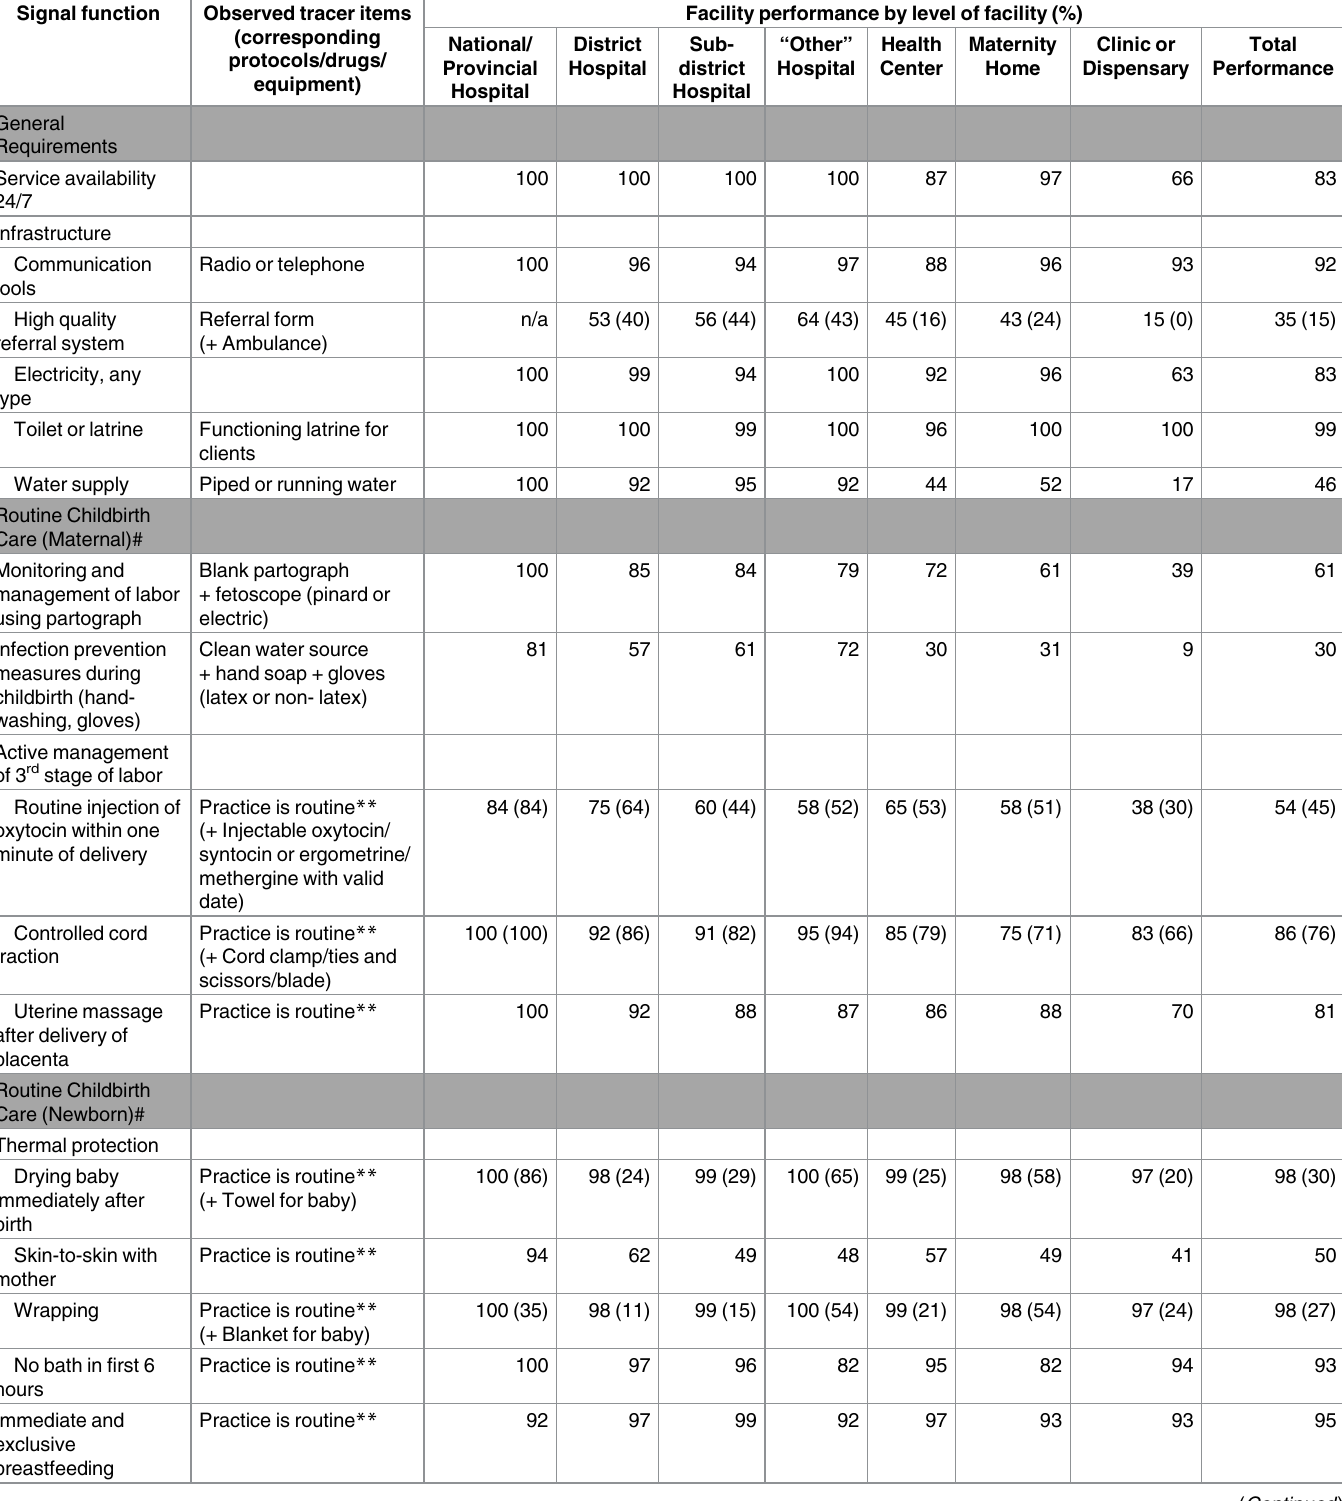
Table 4. Routine childbirth care capability by facility